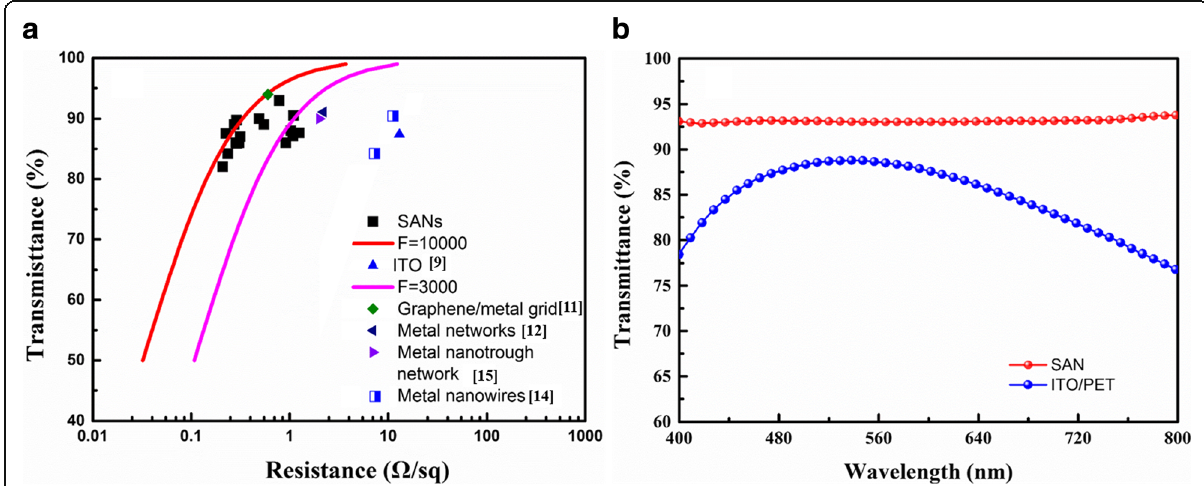
Fig. 2 Optoelectronic properties of the metallic networks. a Optical transmittance of metallic networks as a function of sheet resistance. b Transmittance versus wavelength of the SAN and a ITO/PET